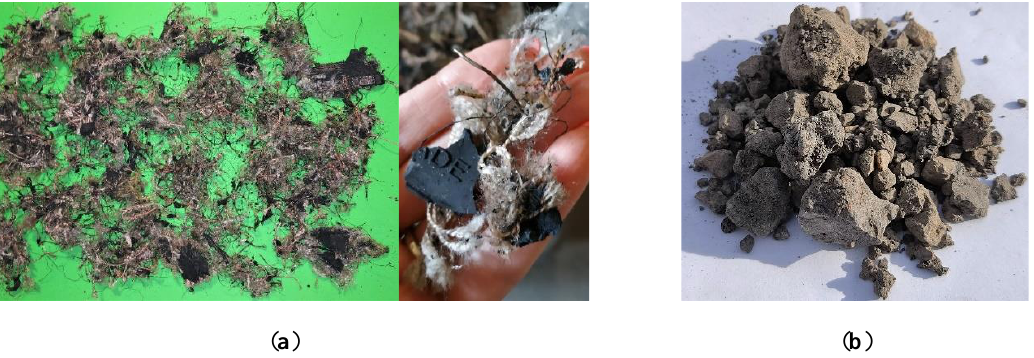
Figure 2. ( a ) representative samples of RTSF; ( b ) EAFS aggregates (0 – 20 mm) before division into fractions. Table 3. Element composition of the EAFS and FA by XRF, SEM-EDS and XRD analysis [%].